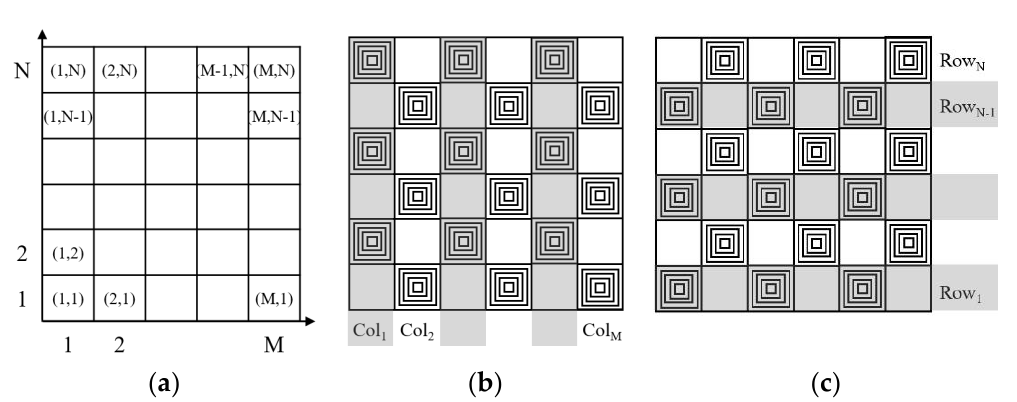
Figure 1. Proposed detection coil array. ( a ) Layout table for the detection coils. ( b ) The first layer detection coil array. ( c ) The second layer detection coil array.